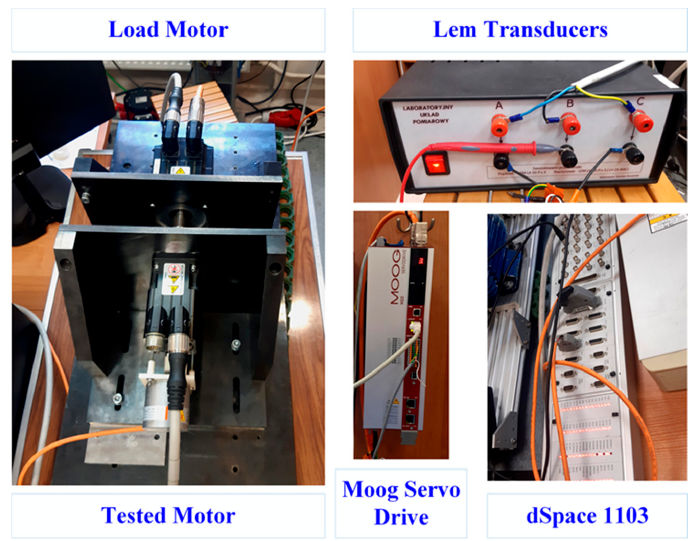
Figure 8. Photos of experimental set-up elements.